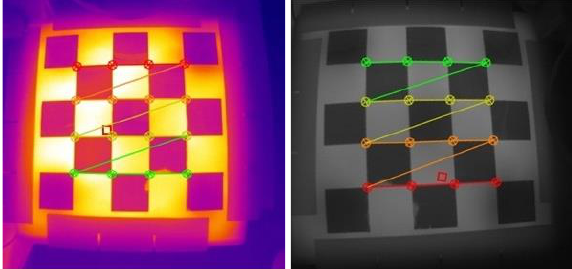
Figure 5: View of a heated chessboard for IR camera calibration: coloured (left) and original (right) images with detected tie points.